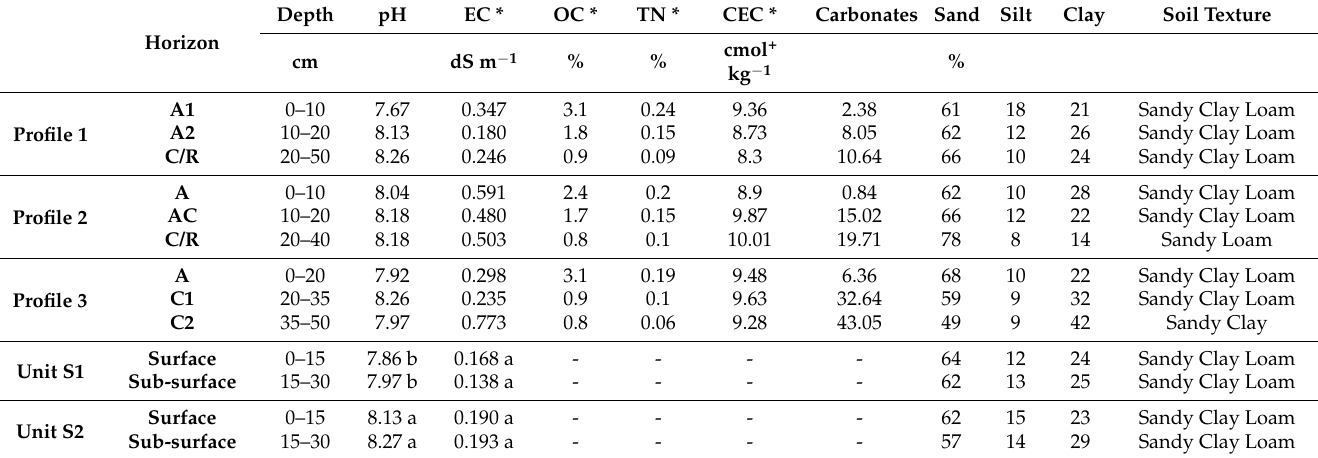
Table 1. Geochemical properties of soil in studied